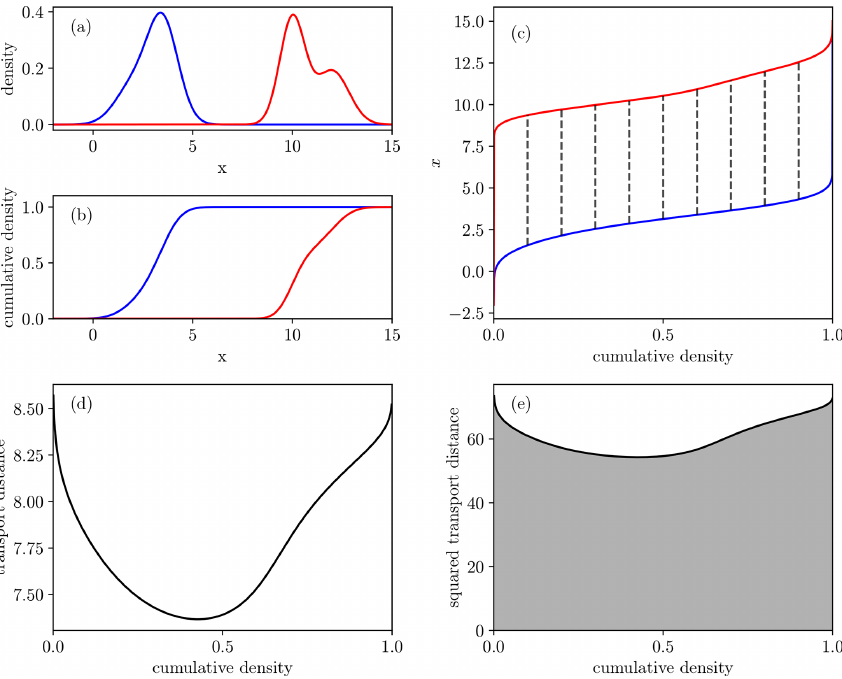
Figure 7. Process of moving from densities to 2-Wasserstein distance in one spatial/temporal dimension x . (a) Density functions from Fig. 4. (b) The cumulative distributions. (c) The inverse cumulative distributions with dashed lines showing transport pairs. (d) The difference between the inverse cumulative densities. (e) The area under the squared difference, giving the squared 2-Wasserstein distance.